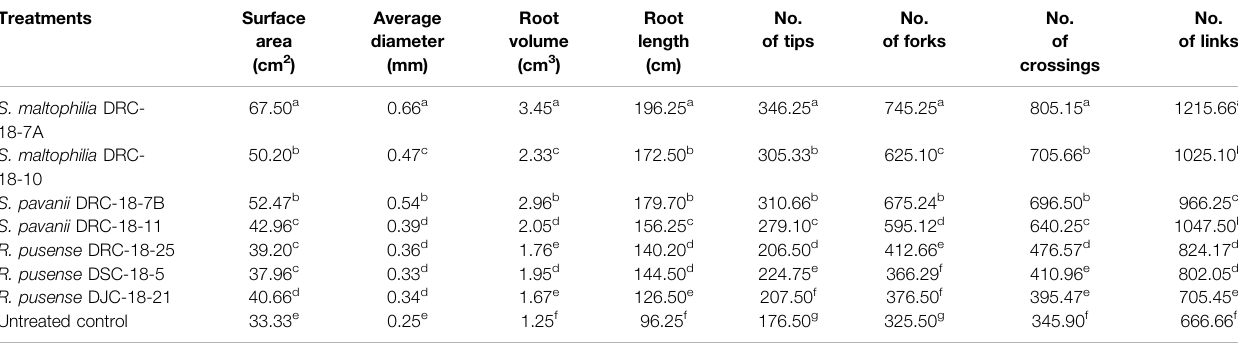
TABLE 3 | Effect of microbial inoculation on root development and attributes in pigeonpea grown in pots at 30 days of sowing.